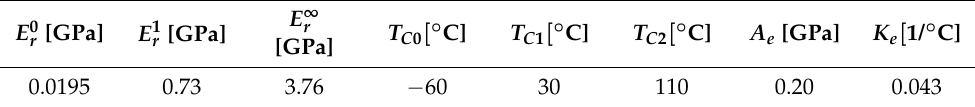
Table 3. Parameters used in the CHILE model to characterize the instantaneous elastic modulus of the resin system (reproduced from [41] with the